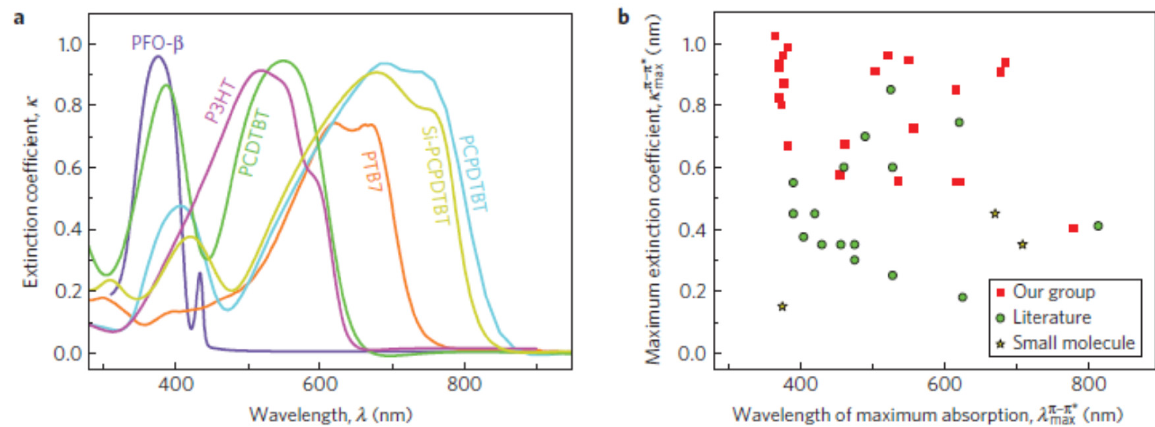
Figure 9. UV–Vis spectra ( a ) and wavelength of maximum absorption of conjugated polymers ( b ). Reproduced with permission from [32] Copyright © 2021, Springer Nature.